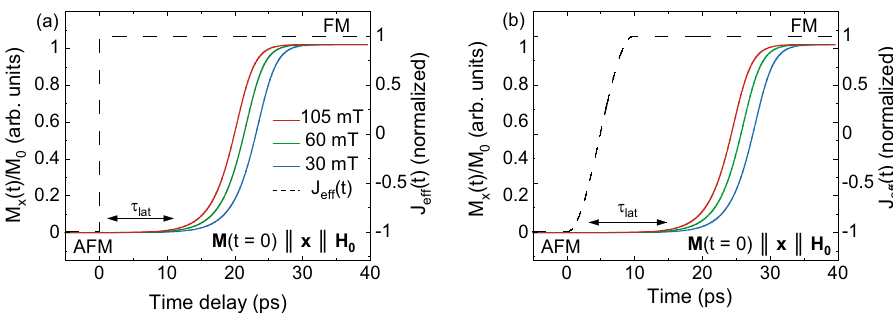
Fig. 8 Simulated net magnetization M(t) using a model that mimics the behavior of FeRh using 2 macrospins. The simulations assume that the (cid:6) (cid:6) (cid:6) (cid:6) ¼ 24 : 8 meV/ μ 2 , M ¼ 0 : 1 μ ; A ¼ 4 j J j ; λ ¼ 0 : 025, λ ¼ 0 : 2 λ = 2 6,37,48 . The system starts in the collinear magnetic parameters are J eff 0 eff ex so ex and g antiferromagnetic (AFM) phase with spins along the x-axis (analogous results are obtained for other initial orientations). The dashed and solid lines indicate the normalized exchange constant (J eff ) and magnetization, respectively. In a J eff changes sign instantaneously while for b it changes at the time- scale of the lattice-expansion. In either case, after demagnetization of the antiferromagnetic vector, ferromagnetic (FM) order along the ^ x -axis grows only after a latency period τ lat (cid:5) 10 ps. The speed at which ferromagnetic order emerges at τ lat depends on the magnitude of the external magnetic fi eld